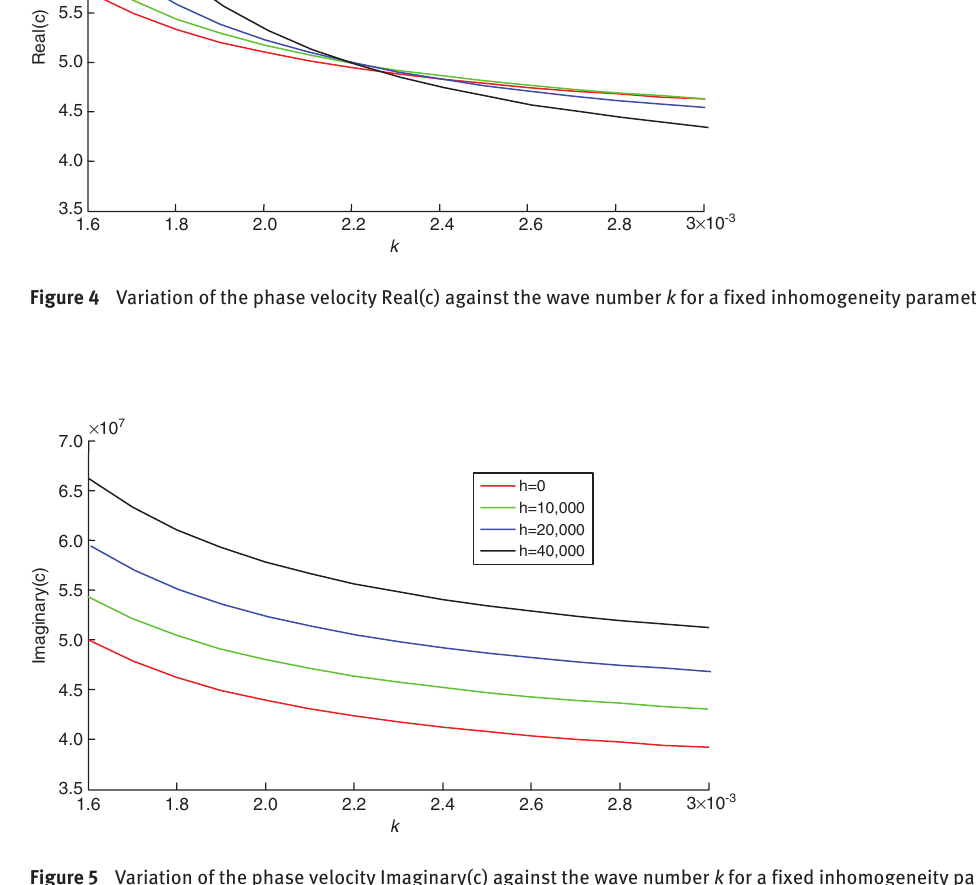
Figure 5 Variation of the phase velocity Imaginary(c) against the wave number k for a fixed inhomogeneity parameter ε = 0.0015.